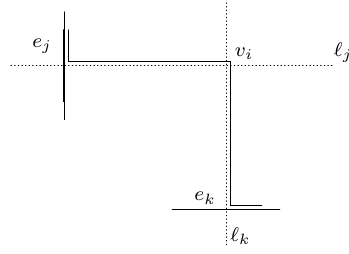
Fig. 5: The construction for 2-regular acyclic orientable graphs.